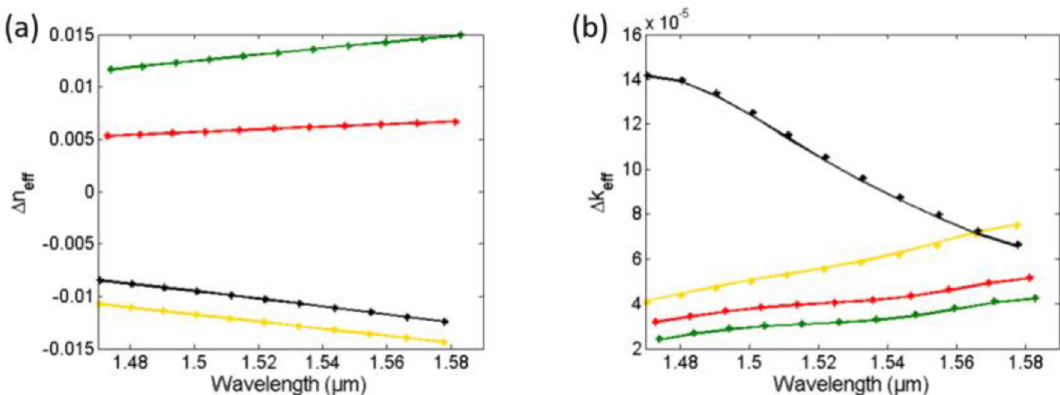
Figure 4. Actual "solid" (from FDE simulation) and detected "asterisk" (from our method) mode effective index change versus wavelength for different sensing media ( a ) Real part Δn eff and ( b ) Imaginary part Δk eff .